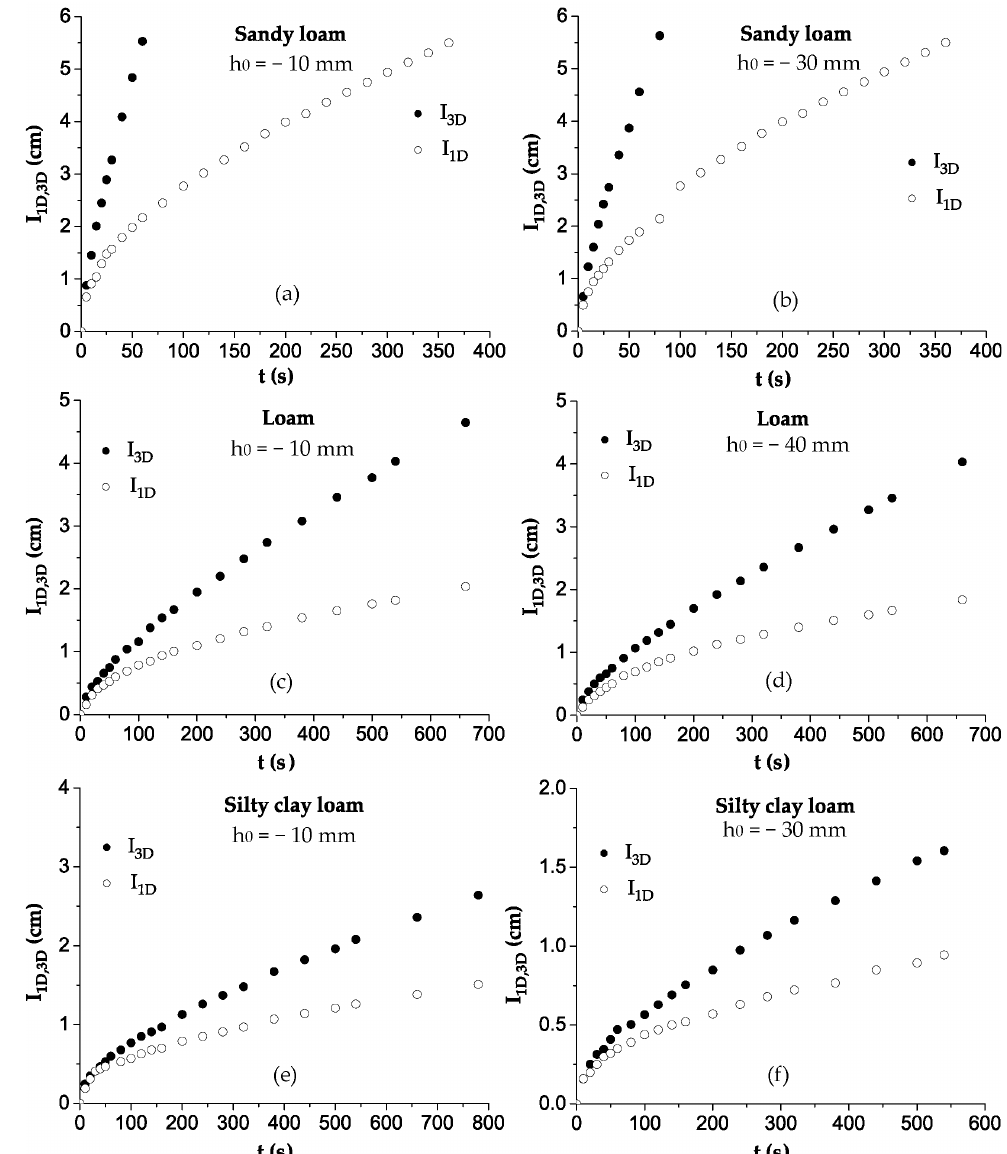
Figure 1. Representation of three- and one-dimensional experimental cumulative infiltration data with time, I 1D,3D (t), for various pressure heads: ( a ) h 0 = − 10 mm and ( b ) h 0 = − 30 mm for sandy loam soil; ( c ) h 0 = − 10 mm and ( d ) h 0 = − 40 mm for loam soil; and ( e ) h 0 = − 10 mm and ( f ) h 0 = − 30 mm for silty clay loam soil.